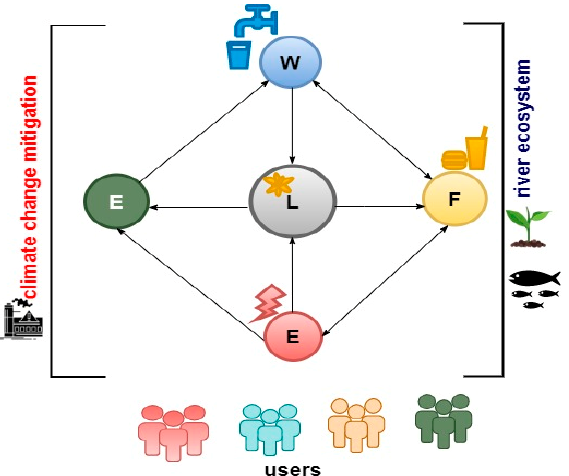
Figure 1. Schematic representation of the land-water-food-energy-environment nexus (LWFEEN) under climate change mitigation and river ecosystem service ( L—land; W—water; F—food; E—energy; E—environment ).